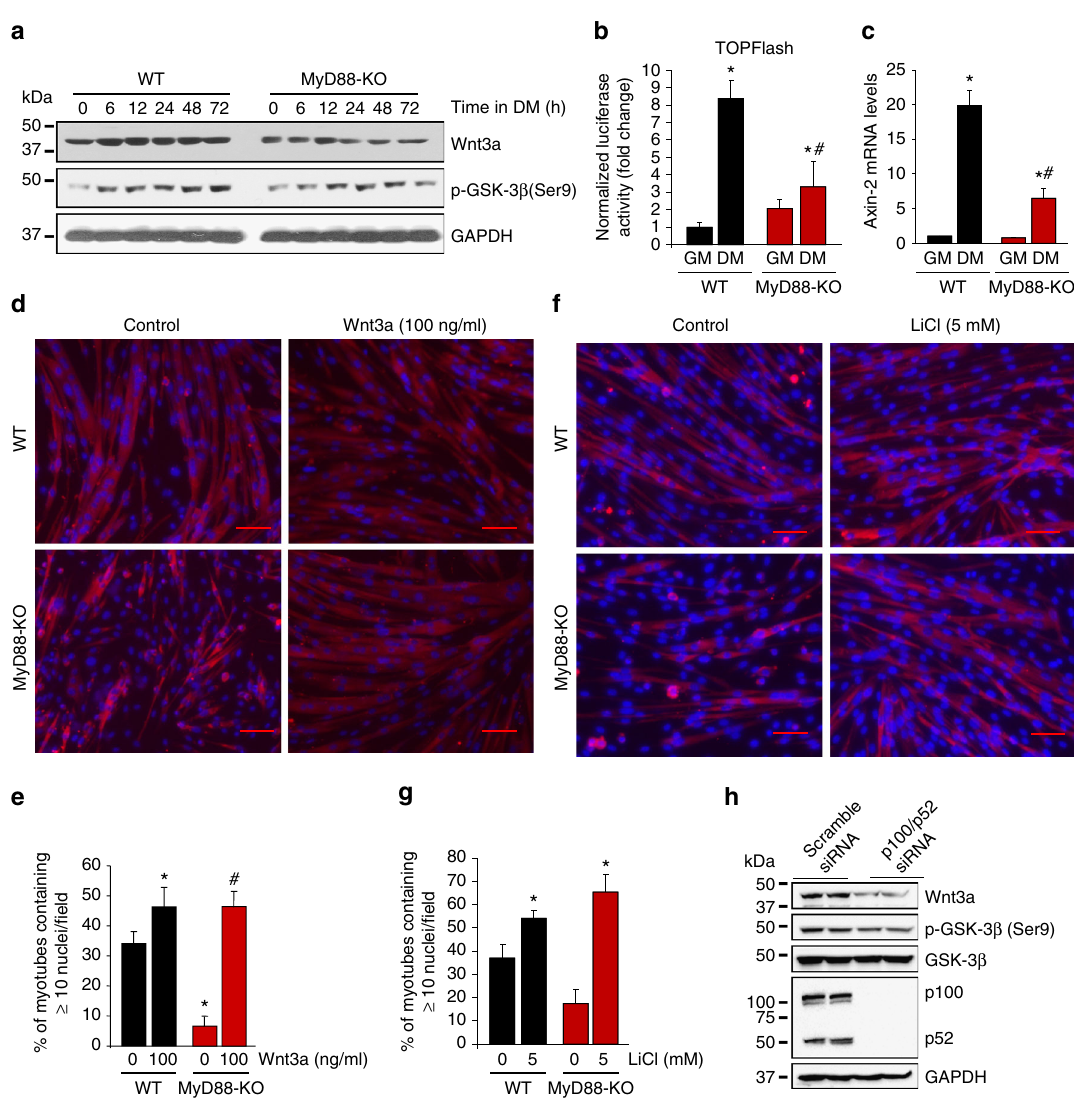
Fig. 5 MyD88 mediates myoblast fusion through canonical Wnt pathway. a Primary myoblasts of WT and MyD88-KO mice were plated at equal densities, incubated in DM, and samples were collected at indicated time points. Immunoblots demonstrate the levels of Wnt3a, p-GSK-3 β , and unrelated protein GAPDH. b WT and MyD88-KO myoblasts were co-transfected with Super (8X) TOPFlash reporter plasmid and Renilla luciferase plasmid (1:10 ratio) and were incubated in growth medium (GM) or DM for 48 h. The cells were then collected and luciferase activity was measured. c WT and MyD88-KO myoblasts were incubated in GM or DM for 48 h and mRNA levels of Axin-2 were measured by performing QRT – PCR assay. For b and c , N = 4 in each group. * p < 0.05 from WT cultures incubated in GM. # p < 0.05 from WT cultures incubated in DM. d WT and MyD88-KO primary myoblasts were plated at equal densities and incubated with DM with vehicle alone or with 100 ng/ml Wnt3a protein. The cultures were fi xed and stained with anti-MyHC and DAPI. Representative photomicrographs are presented here. Scale bar: 50 µ m. e Quanti fi cation of the percentage of myotubes containing ≥ 10 nuclei in control and Wnt3a-treated WT and MyD88-KO cultures. N = 4 in each group. * p < 0.05 from WT cultures without Wnt3a by unpaired t -test. # p < 0.05 from MyD88-KO cultures without Wnt3a protein by unpaired t -test. f WT and MyD88-KO primary myoblasts were plated at equal densities and incubated with DM with vehicle alone or 5 mM LiCl for 48 h. The cultures were fi xed and stained with anti-MyHC and DAPI. Representative photomicrographs are presented here. Scale bar: 50 µ m. g Quanti fi cation of the percentage of myotubes containing ≥ 10 nuclei in vehicle alone and LiCl-treated WT and MyD88- KO cultures. N = 4 in each group. Error bars represent s.d. * p < 0.05 from WT cultures without LiCl by unpaired t -test. # p < 0.05 from MyD88-KO cultures without LiCl by unpaired t -test. h Primary WT myoblasts were transfected with scrambled siRNA or p100/p52 siRNA. After 36 h, the cells were incubated in DM for 48 h followed by analysis by Western blot. Immunoblots presented here demonstrate the levels of Wnt3a, p-GSK-3 β , GSK-3 β , p100/p52,